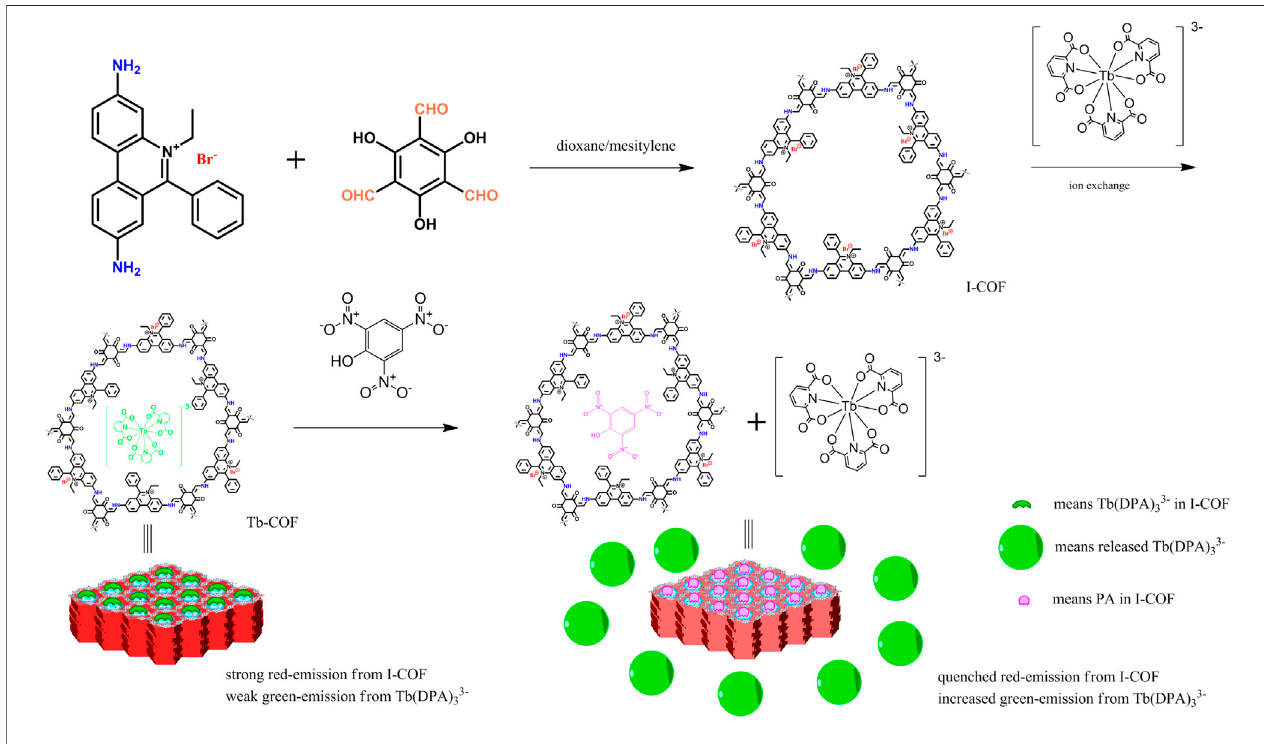
SCHEME 1 | Synthetic route and sensing strategy of I-COF and Tb-COF.